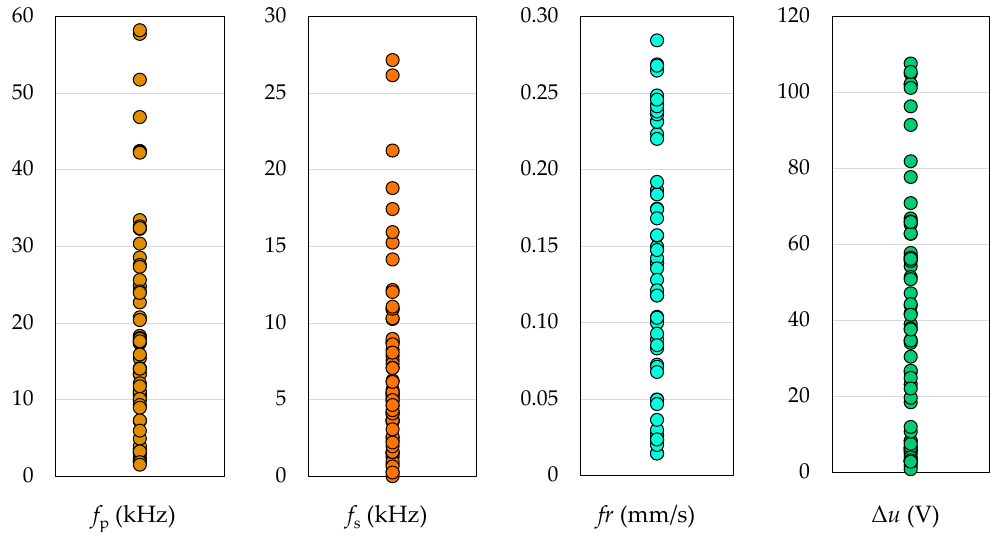
Figure 4. Plots of the data sets for the four potential indicators for the process fingerprint. Each data point corresponds to one of the 64 experimental runs.